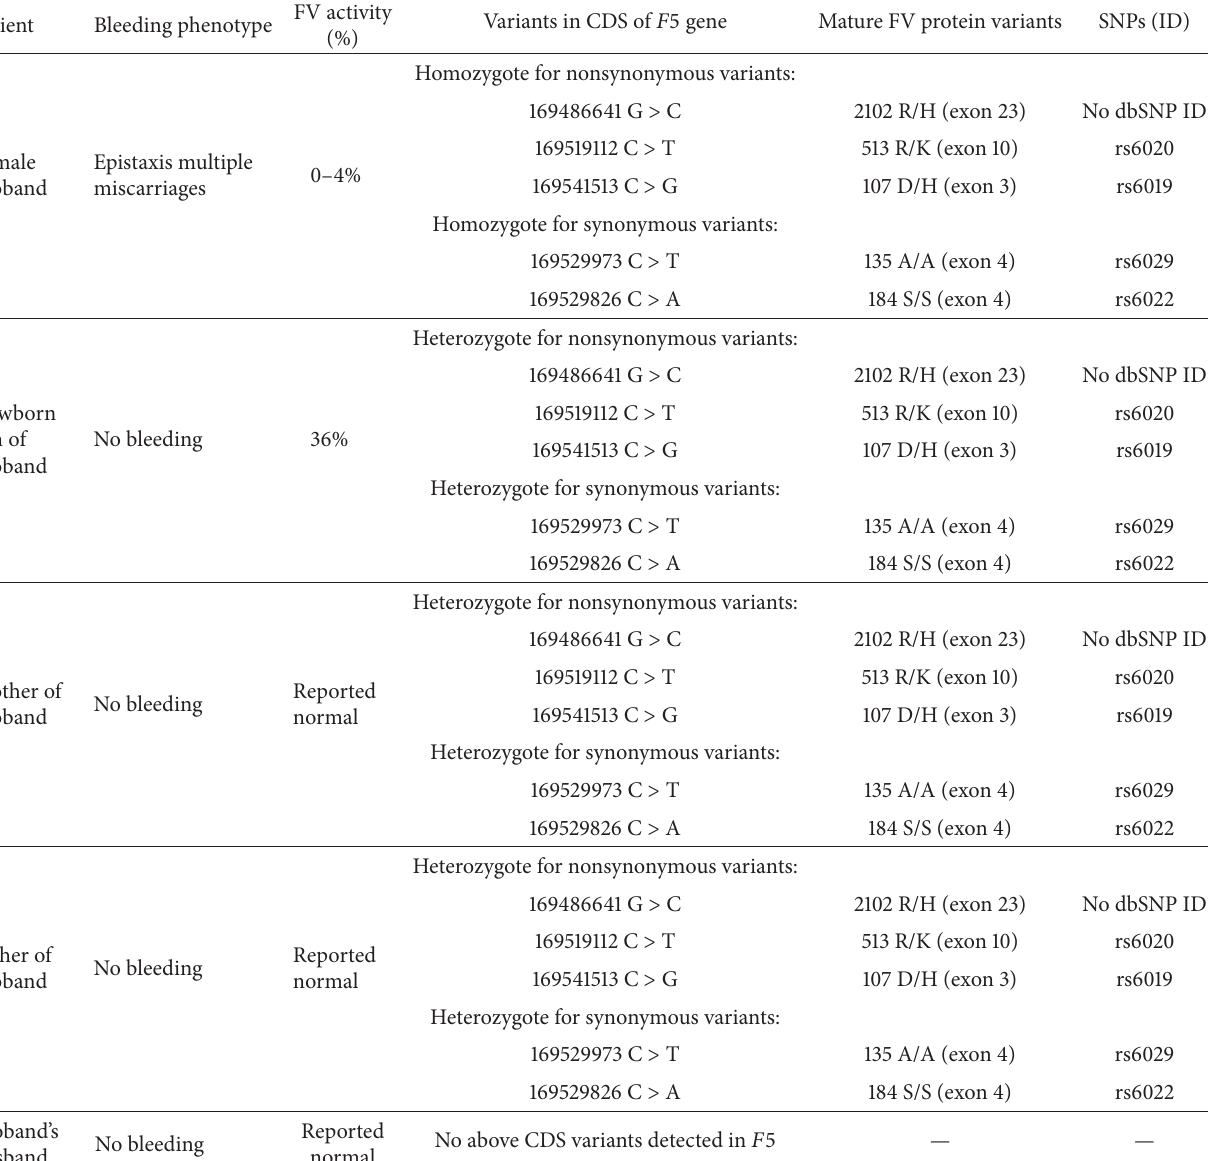
Table 2: Mutations observed in coding sequences (CDS) of 𝐹5 gene in the investigated proband and her blood